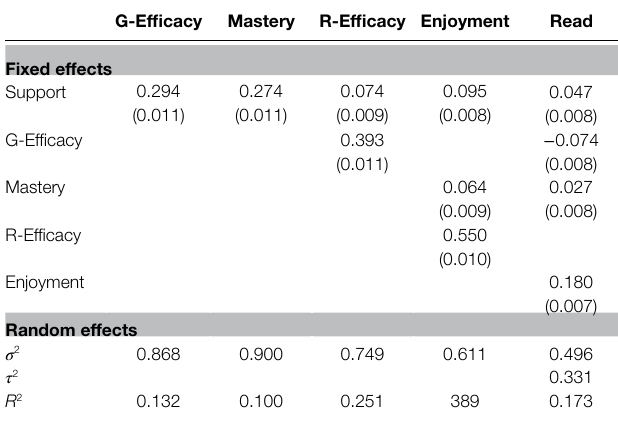
TABLE 7 | Parameter estimates of the finalized